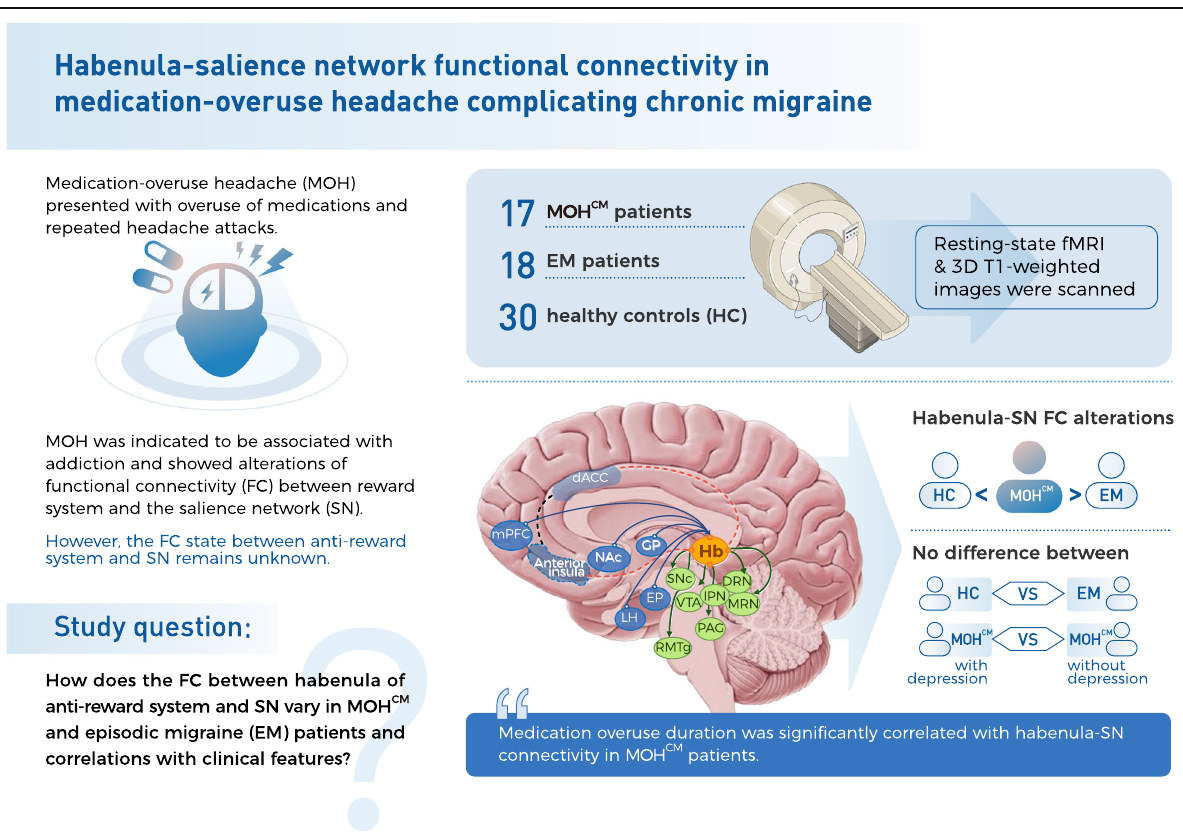
Fig. 1 Summary of the current study. This figure is a concise summary of the current study. MOH + CM (medication-overuse headache + chronic migraine) was shown as MOH CM here for a better layout in this figure. The picture of brain on the right shows the habenula and its connections with other brain regions. The full lines with arrows connect regions which the habenula has afferent inputs from or efferent outputs to on structural basis. The dotted lines represent functional connectivity identified by fMRI studies. Hb, habenula; SNc, substantia nigra pars; IPN, interpeduncular nucleus; DRN, dorsal raphe nucleus; MRN, median raphe nucleus; VTA, ventral tegmental area; PAG, periaqueductal gray; RMTg, rostromedial tegmental nucleus; EP, entopeduncular nucleus; NAc, nucleus accumbens; CP, caudate/putamen; LH, lateral hypothalamic;